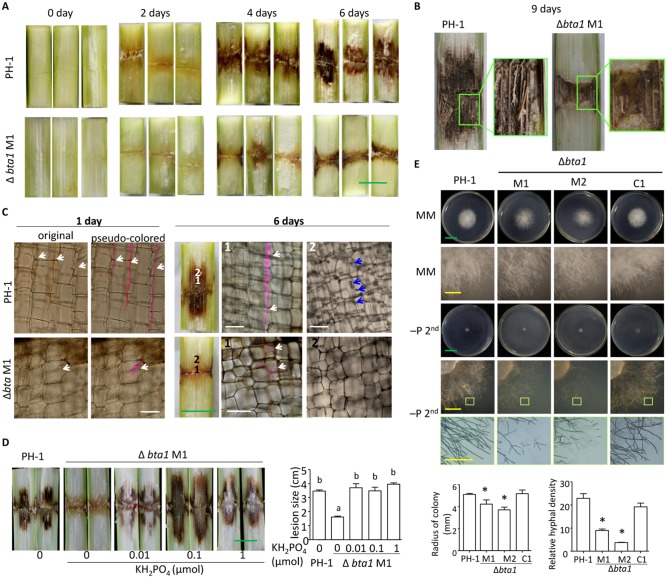

graminearum bta1 mutants show reduced virulence in maize stalk infection and reduced growth on phosphate depleted media.
F. (A)-(C) Maize stalks infected by wild-type or mutant F. graminearum at the indicated number of days after inoculation. Note that more vascular strands are visible in the stalk infected by wild-type F. graminearum than that infected by mutant F. graminearum in (B). White arrows point to hyphae (in pseudo pink). Blue arrows point to debris-like structure in host cells. (D) Supplementation with KH2PO4 increased lesion size caused by the bta1 mutant strain. Different letters indicate statistical differences among the strains, according to Tukey’s multiple comparison test (P = 0.05), n = 3 independent experiments. (E) Fungal growth after 2 days of culture on various media. MM: minimal medium, −P: minimal medium lacking phosphate. −P2nd: hyphal disks from −P medium were transferred to fresh −P medium plates to exhaust endogenous phosphate. Statistical analysis for colony radius and relative hyphal densities are charted at the bottom of the panel. The radius was measured at 1 day after transfer onto the −P2nd medium. The relative hyphal density was determined using ImageJ software by measuring the gray value of the same positions of each fungal colony on pictures (subtracted from the respective background gray value). *Significantly different from wild type (P < 0.05) according to Student’s t test, n ≥3. Error bars denote SE.